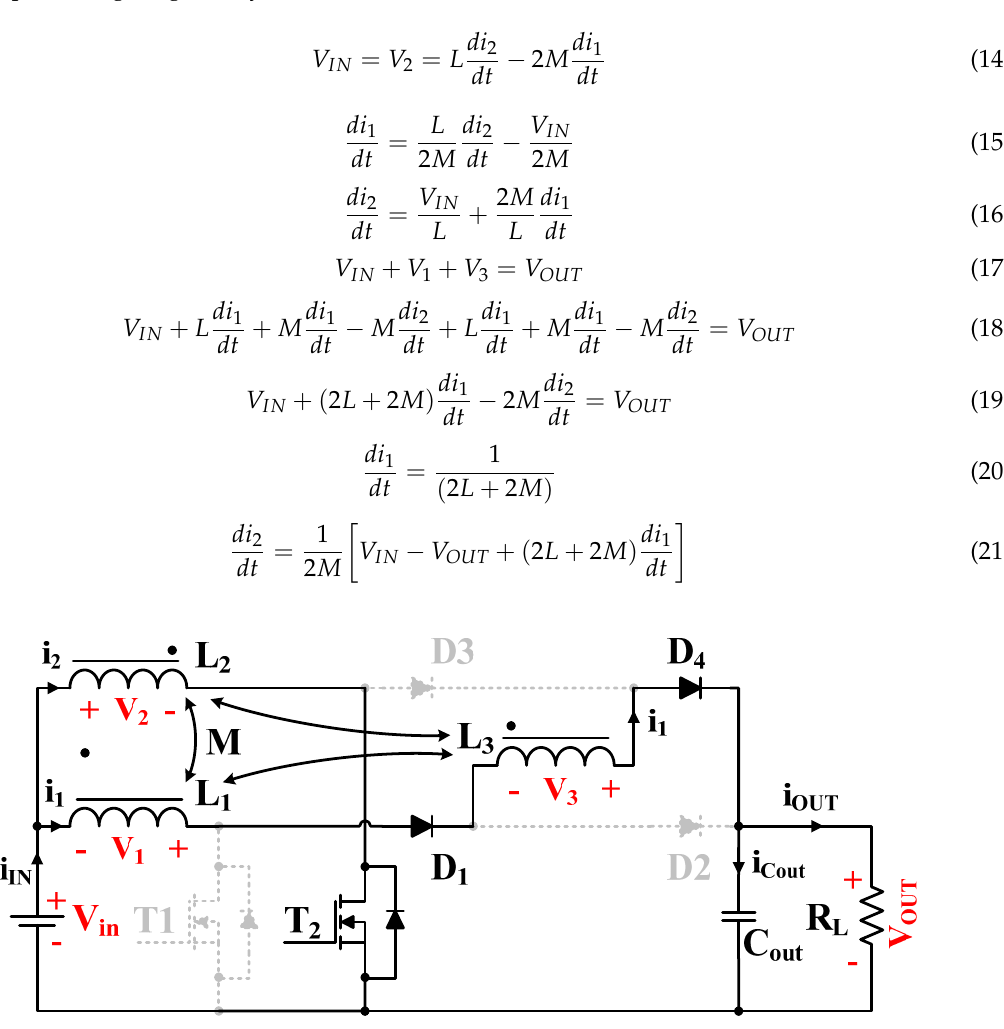
Figure 8. Equivalent circuit of proposed converter operation during 3rd interval.